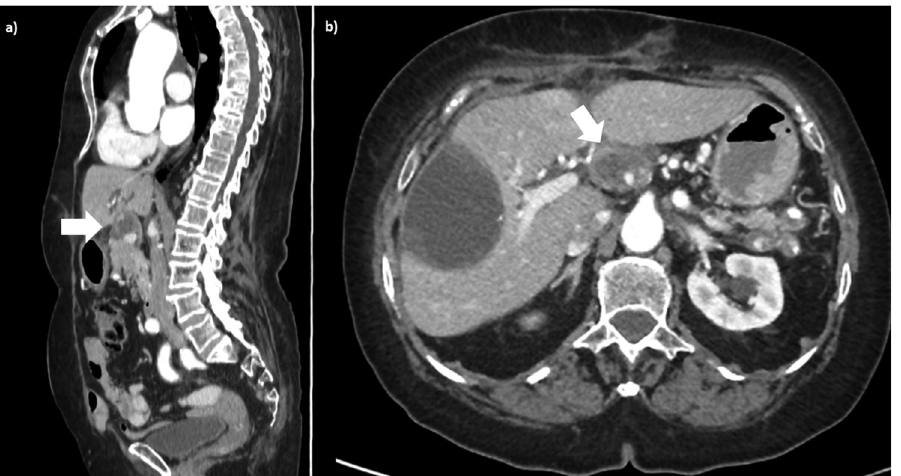
Figure 4: 6 months postoperative follow - up. CT scan during arterial phase of the contrast study, in MPR sagittal plan ( a ) and in axial plane ( b ) : the arrow shows complete thrombosed CHA aneurysm and his vascular